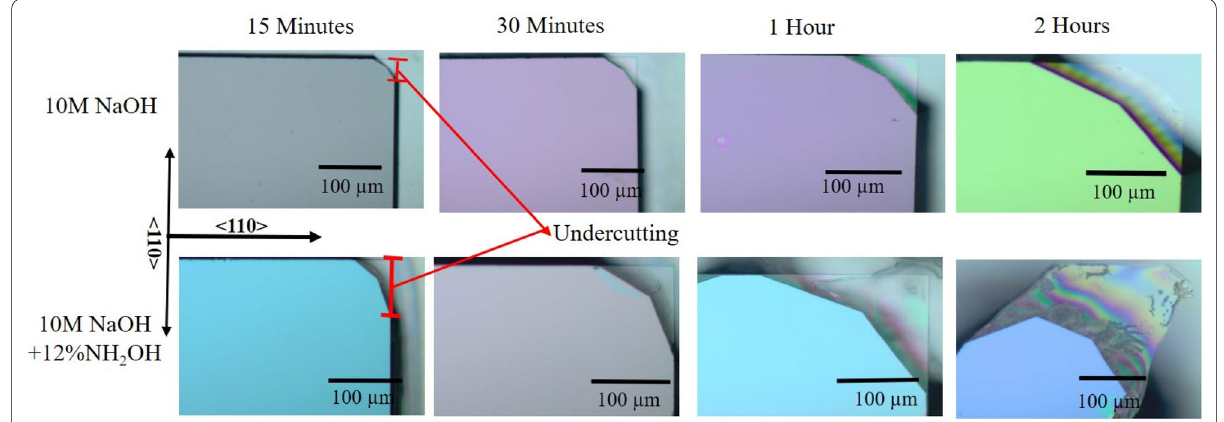
Fig. 4 Optical micrographs of undercutting at convex corners on Si{100}